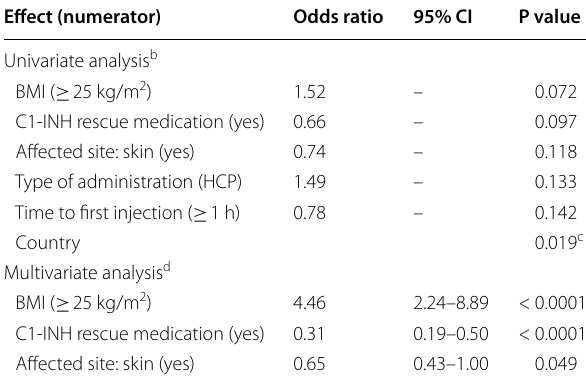
the number of attacks = Table 6 Evaluation of factors affecting time to resolution